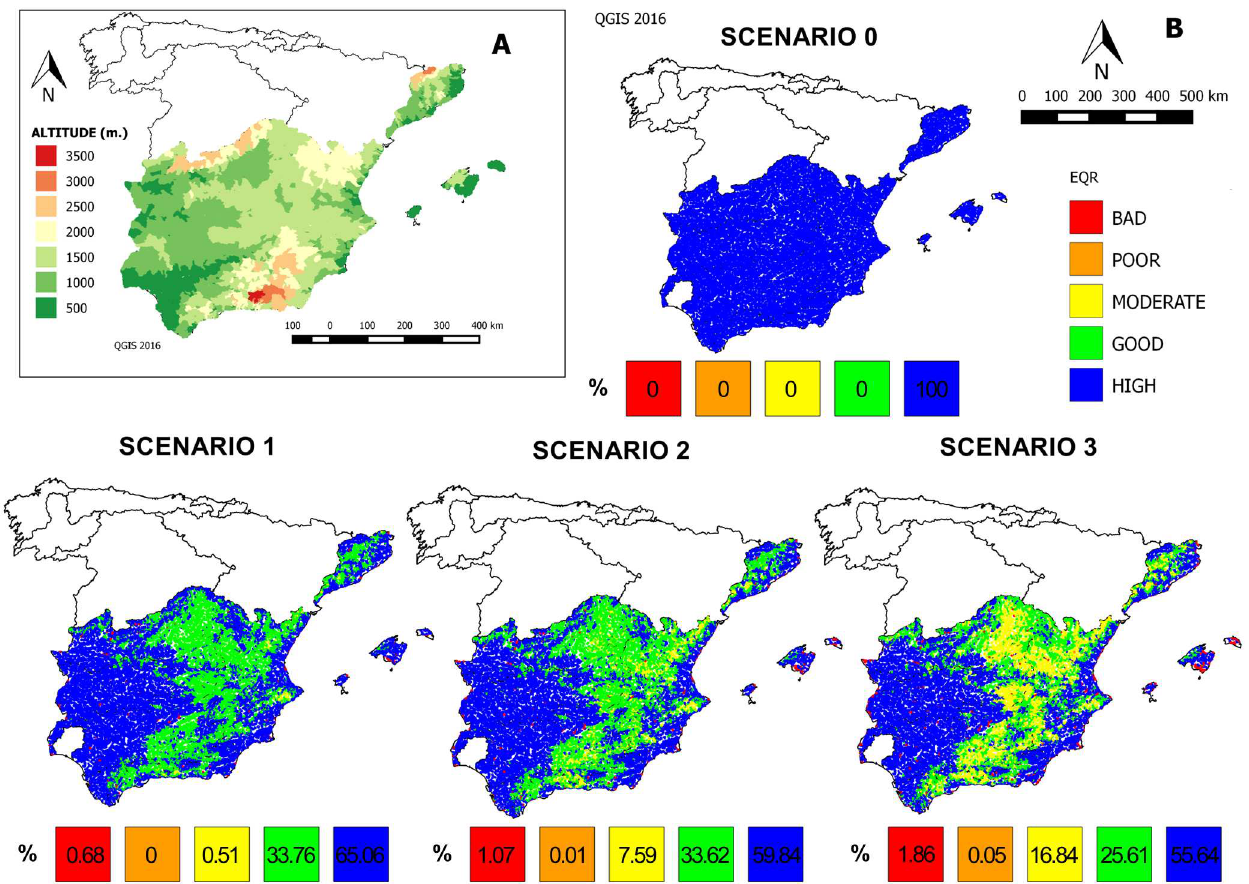
Fig 3. Representation of EQR in the scenarios modelled. A. Altitudinalmap of study area. B. Ecological Quality Ratio (EQR) calculatedfor each grid and scenario: scenario0 (current conditions), scenario1 (+1.70˚C and -10% flow), scenario2 (+2.45˚C and -20% flow), scenario3 (+3.30˚C and -30% flow). Bottom bars indicatethe percentageof grids for each EQR value. Coloursare accordingto the EuropeanWater FrameworkDirective requirements.